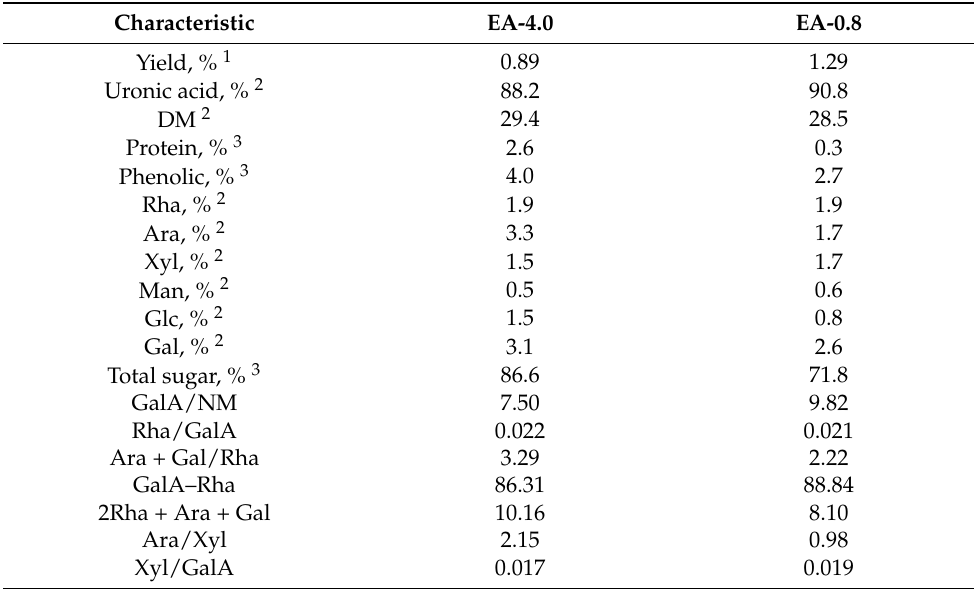
Table 1. Chemical characteristics of the polysaccharide fractions extracted from E. angustifolium .